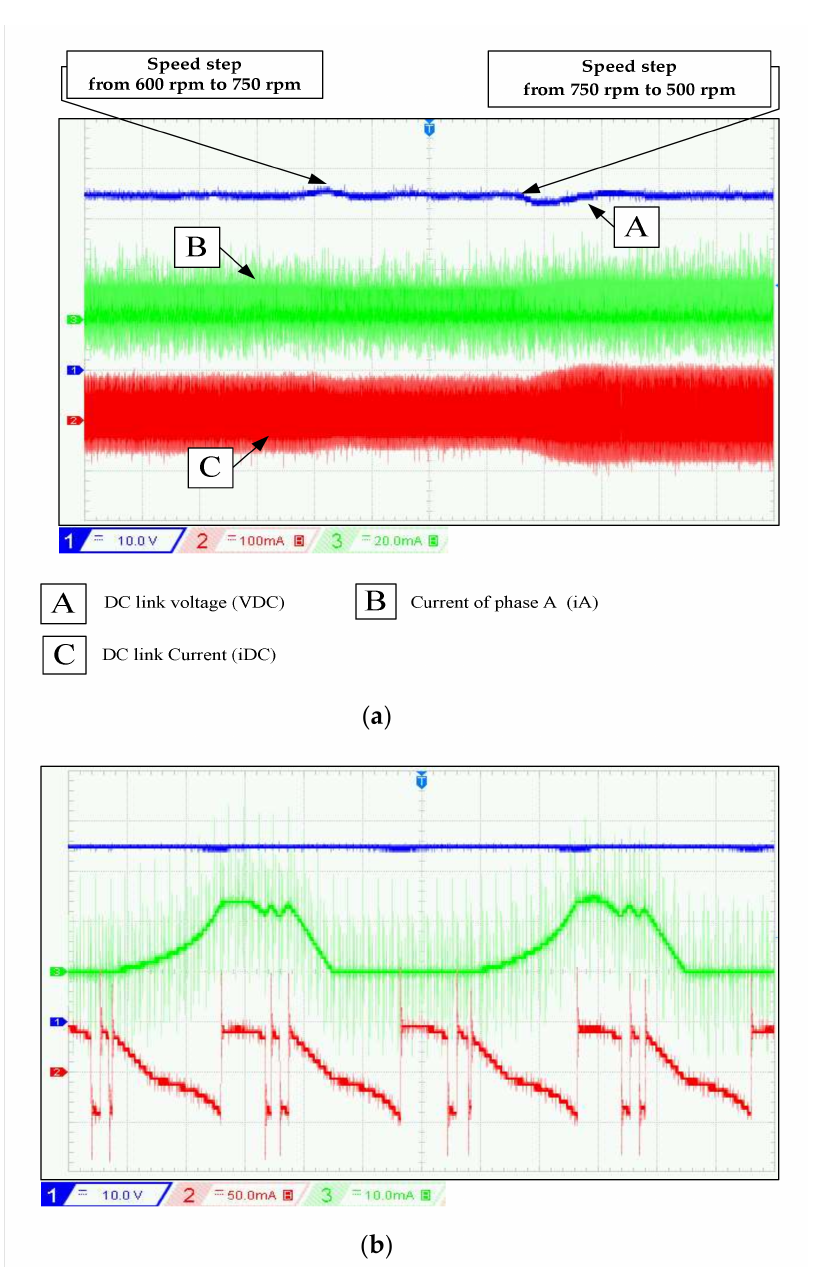
Figure 14. ( a ) Experimental waveforms of DC link voltage, phase current, and DC link current for different shaft speed at R L = 333 Ω and V DC-ref = 70 V, ( b ) Zoom of Figure 14a at w = 500